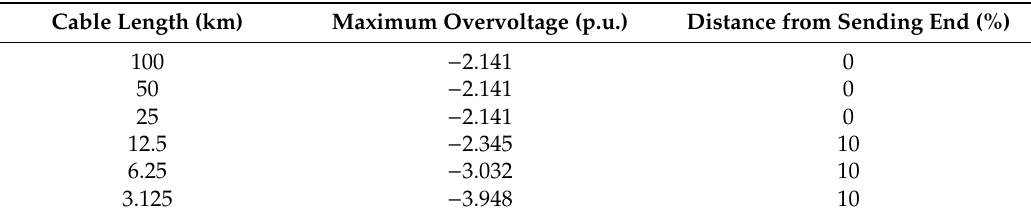
Table 4. Maximum core-ground overvoltage in cables with di ff erent lengths. Cable Length (km) Maximum Overvoltage (p.u.) Distance from Sending End (%)